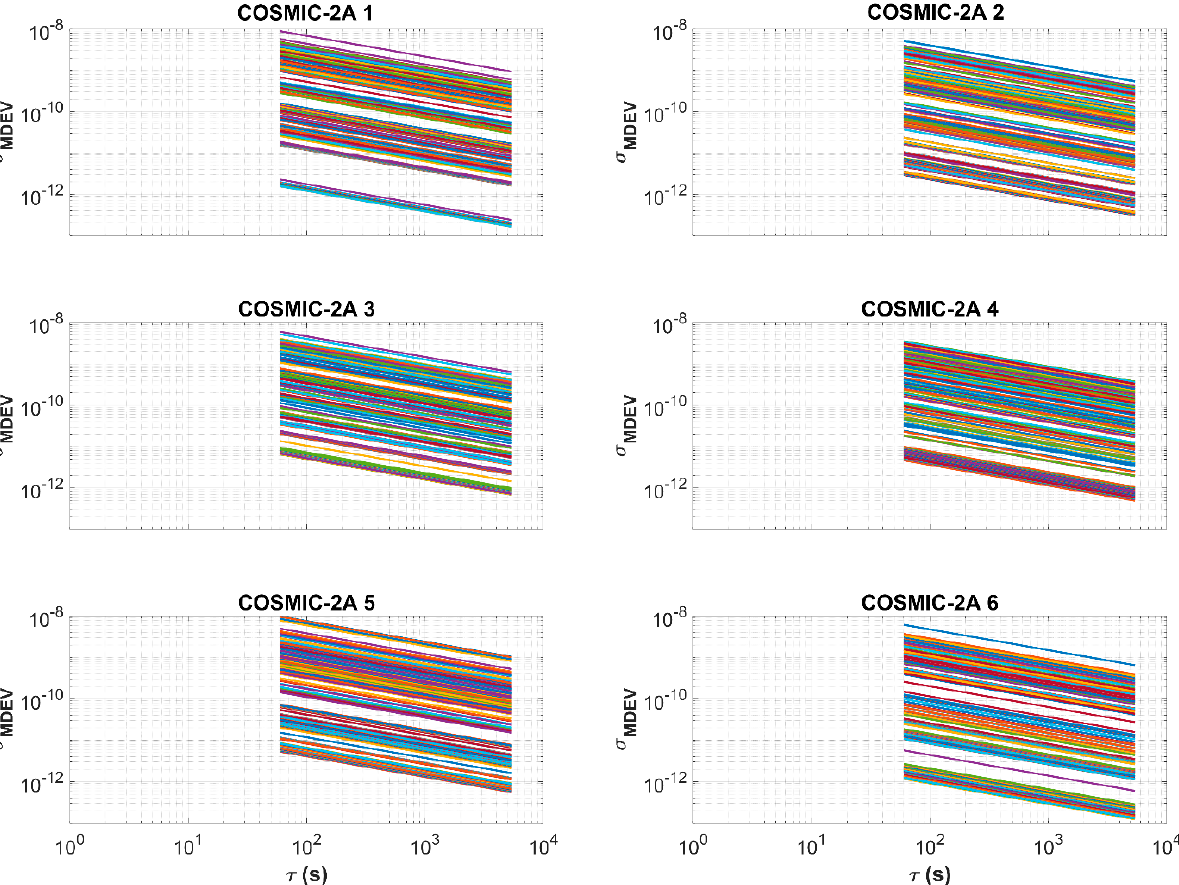
Figure 10. MDEV of the estimated clocks of COSMIC-2 satellites. Different colours are dedicated to the different observation segments of each COSMIC-2 satellite. The duration of the observation segments is varied from 30 min to 2 h, generally around 1.5 h with a sample interval of 10 s. To compare with the CubeSats, the specifications of the COSMIC-2 satellites and their structure are provided in Table 7 and Figure 11.